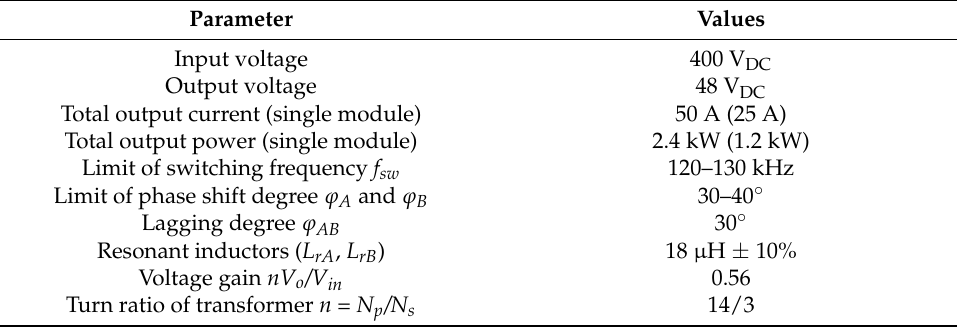
Table 1. Designed parameters of the experiment and